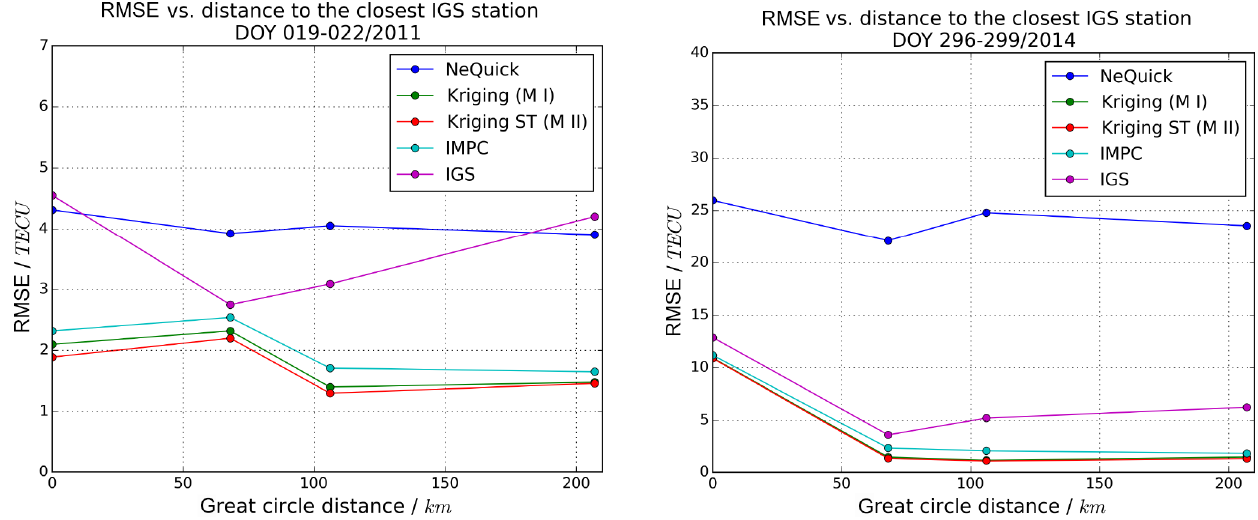
Figure 4. Root mean square error of the STEC estimation vs. the great circle distance of the IGS validation station to the closest IGS station in the surrounding of the validation station (see Table 1). The left-hand figure illustrates the period 019–022/2011 and the right-hand figure the period 296–299/2014. The IGS validation stations are (beginning with the smallest great circle distance) “mad2”, “spt0”, “pots” and “ieng”. The STEC estimates are obtained by the NeQuick model (blue), the kriging with spatial covariance MI (green), the kriging with spatial–temporal covariance MII (red), the IMPC TEC maps (cyan) and the IGS TEC maps